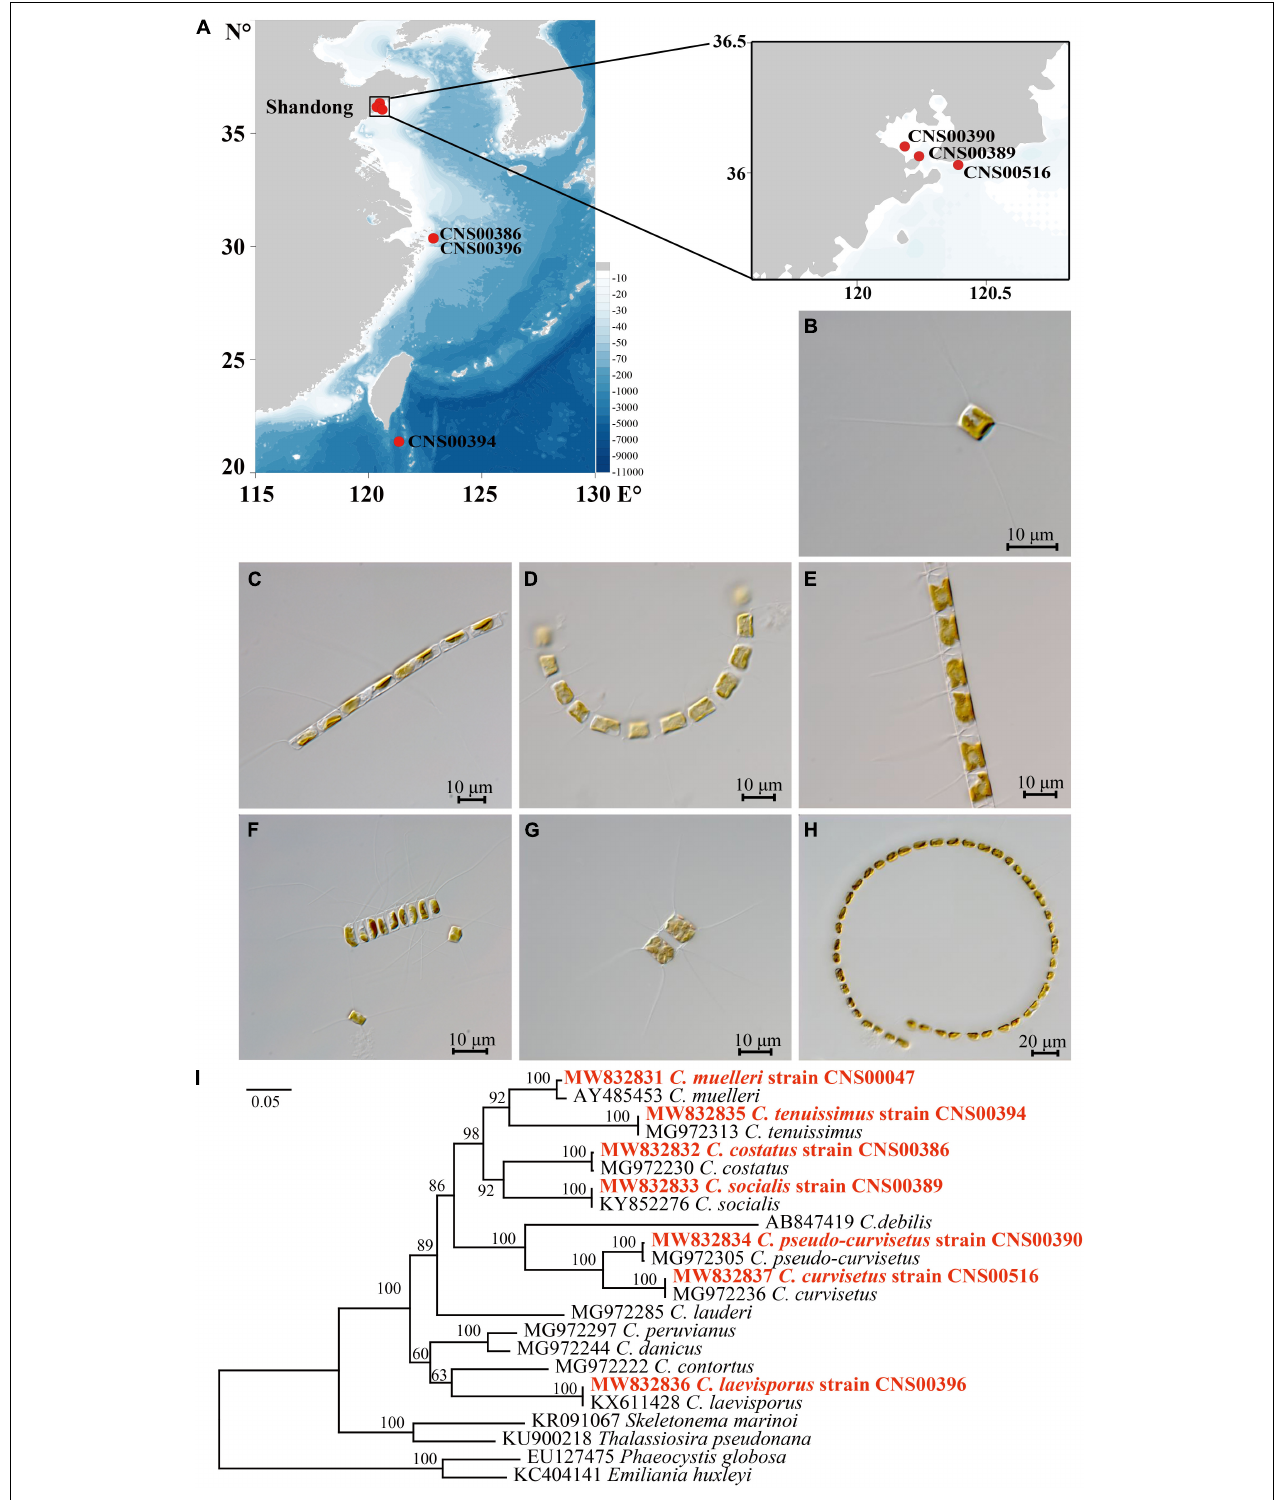
FIGURE 1 | (A) Sampling locations of Chaetoceros species. (B–H) The micrographs of Chaetoceros species. (B) C. muelleri (strain CNS00047). (C) C. costatus (strain CNS00386). (D) C. socialis (strain CNS00389). (E) C. pseudo-curvisetus (strain CNS00390). (F) C. tenuissimus (strain CNS00394). (G) C. laevisporus (strain CNS00396). (H) C. curvisetus (strain CNS00516). (I) The phylogenetic analysis of Chaetoceros species and outgroups ( Phaeocystis globosa and Emiliania huxleyi ) using full length of 18S rDNA gene.